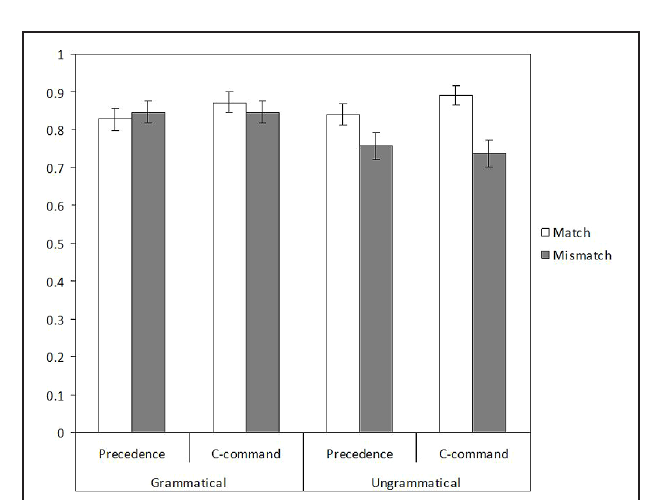
FIGURE 6 | Accuracy proportions in the speeded grammaticality judgment of Experiment